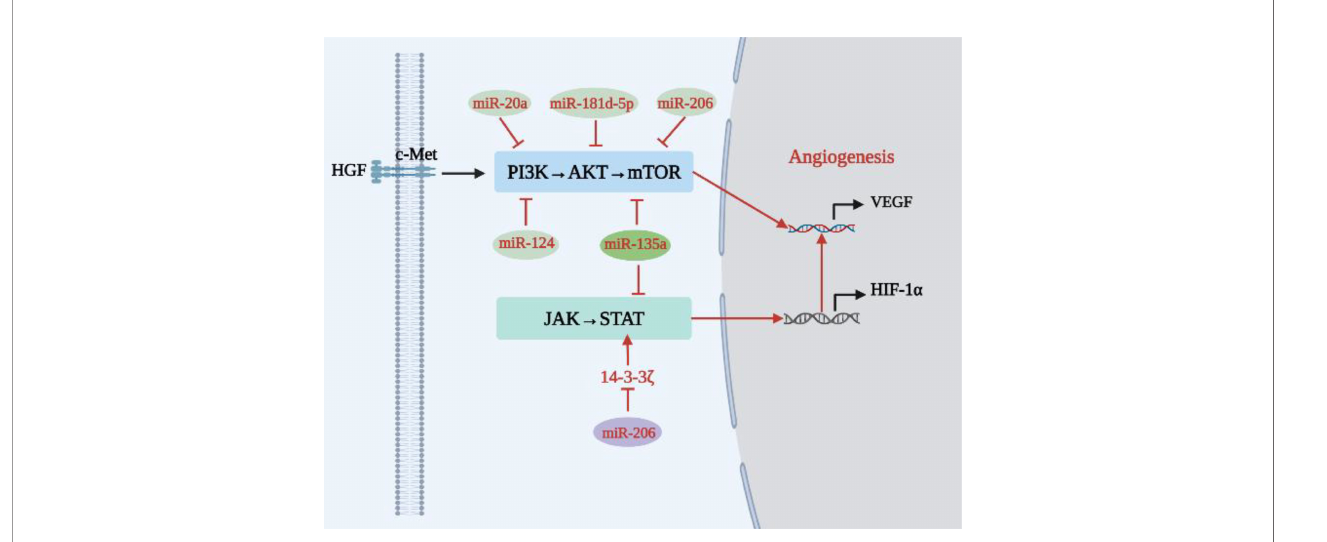
FIGURE 2 | Relationship between tumor suppressor miRNAs and angiogenesis in lung